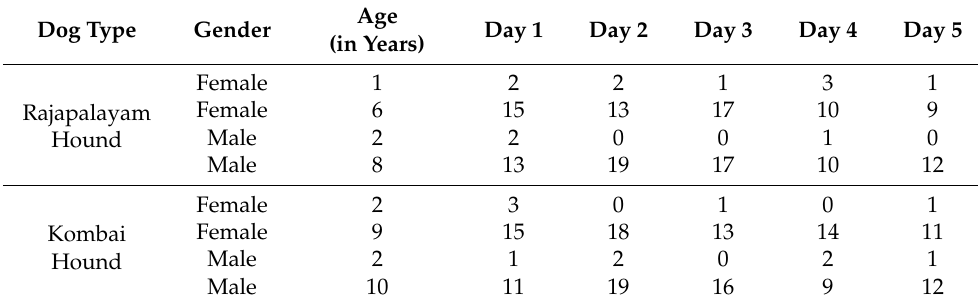
Table A5. Dog Sounds Recorded When Dog is